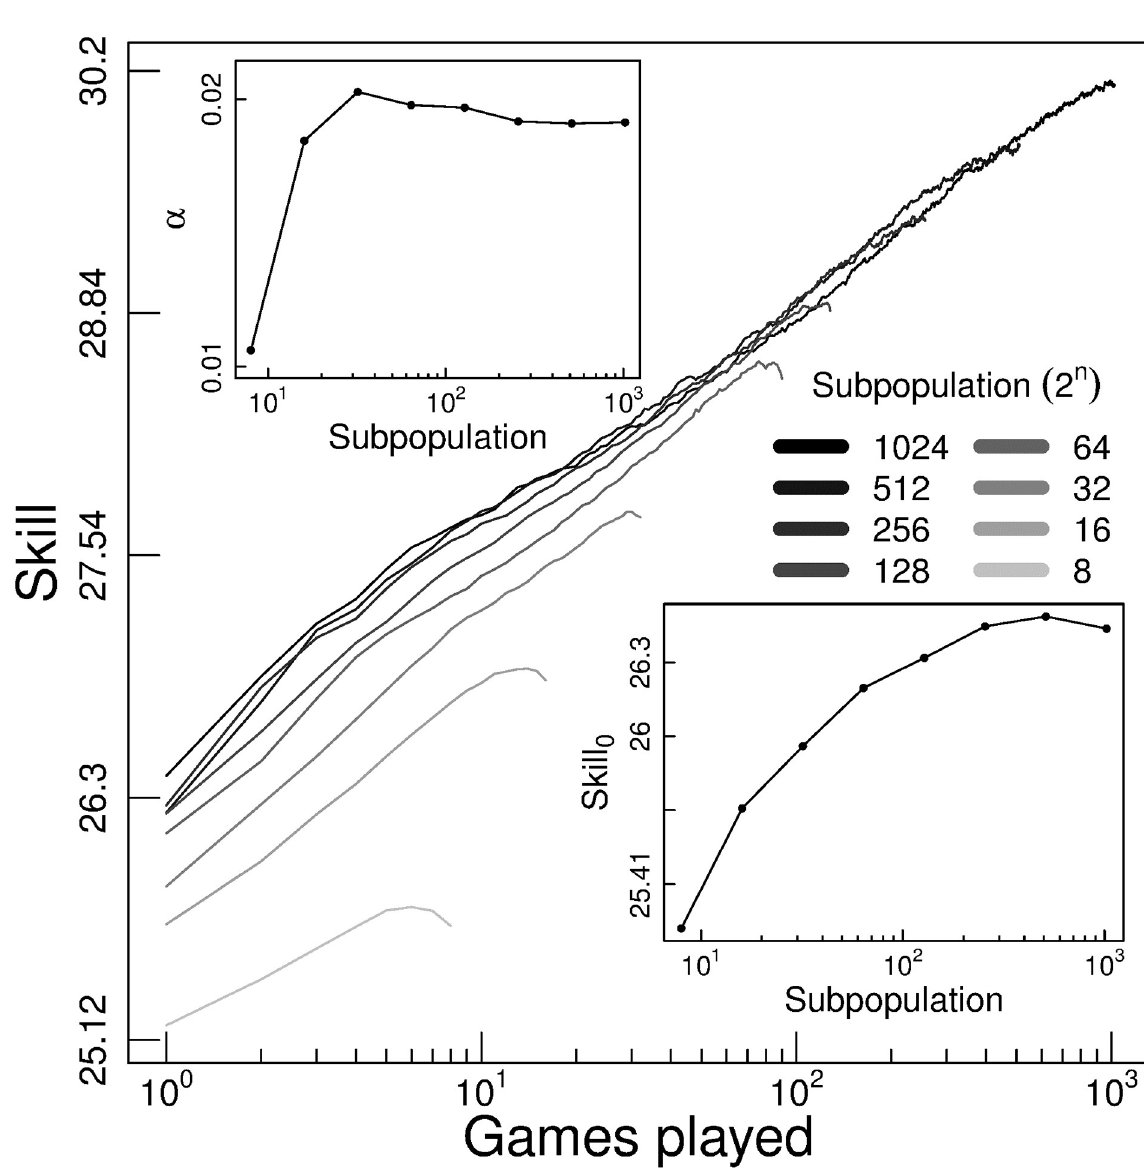
Fig 1. Law of practice. Log-log learning curve of the subpopulation of players with different total activity. Each learning curve shows the skill of the first 2 n games played of the subpopulation with at least 2 n games played and less than 2 n +1 . Subplots show the parameterized values (i.e. α and Skill 0 ) of each learning curve following Eq